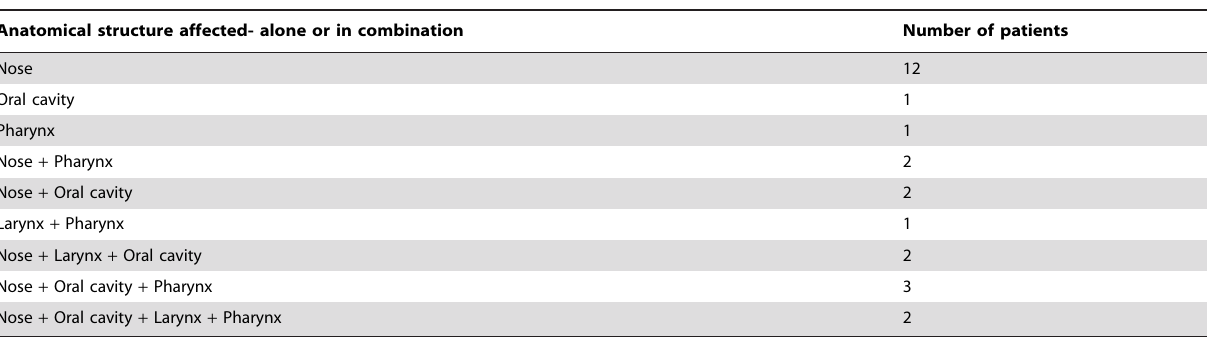
Table 1. Location of the mucous lesions in 26 patients with mucous leishmaniasis.